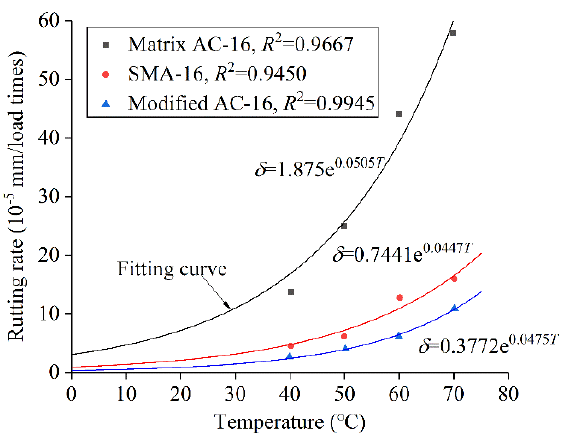
Figure 6. Fitting curves of temperature and rutting rate of the three asphalt mixtures.